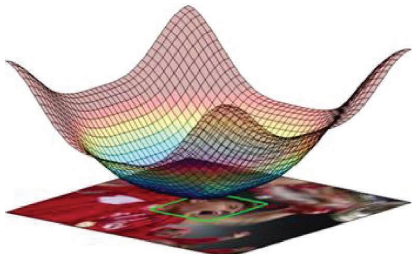
Figure 1: Boundary penalty